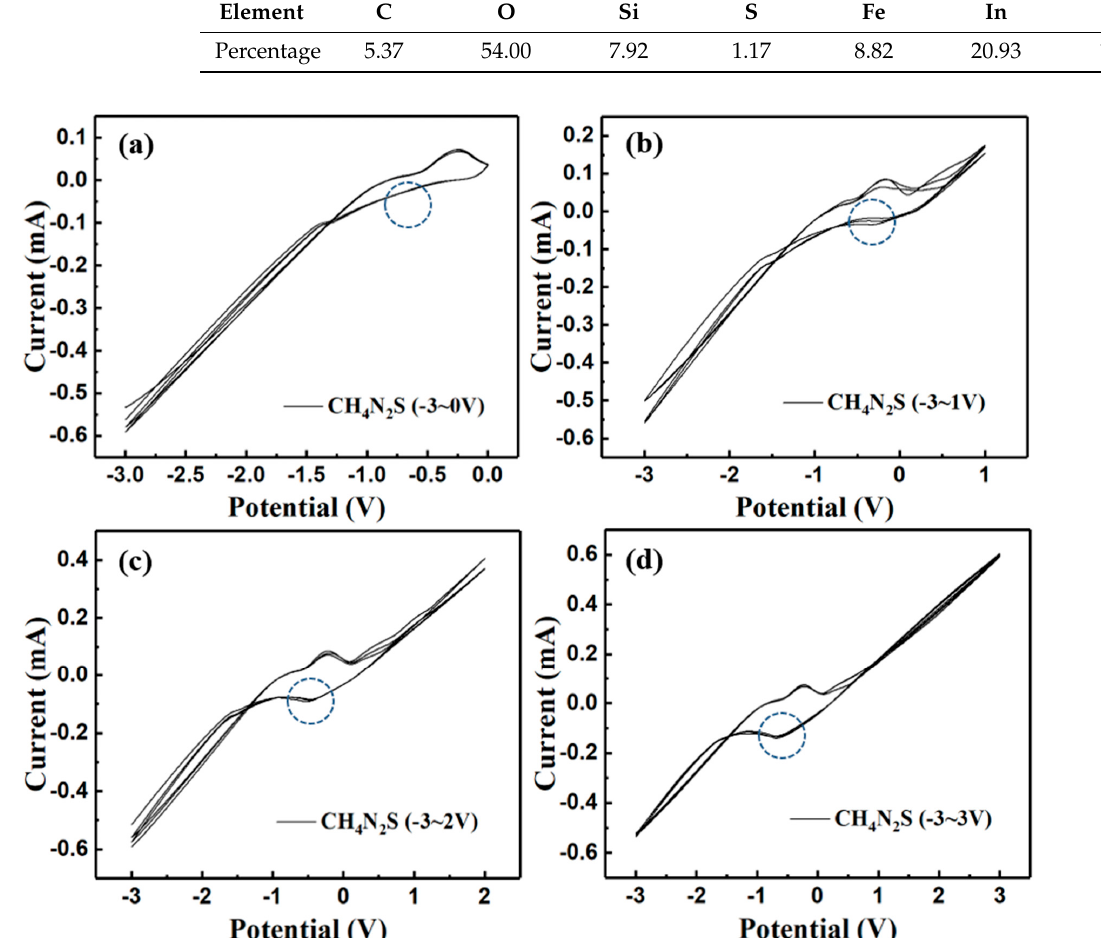
Figure 3. Cyclic voltammograms of Pt in thiourea aqueous solution at different scanning potential ranges of ( a ) -3~0 V, ( b ) -3~1 V, ( c ) -3~2 V, ( d ) -3~3 V.